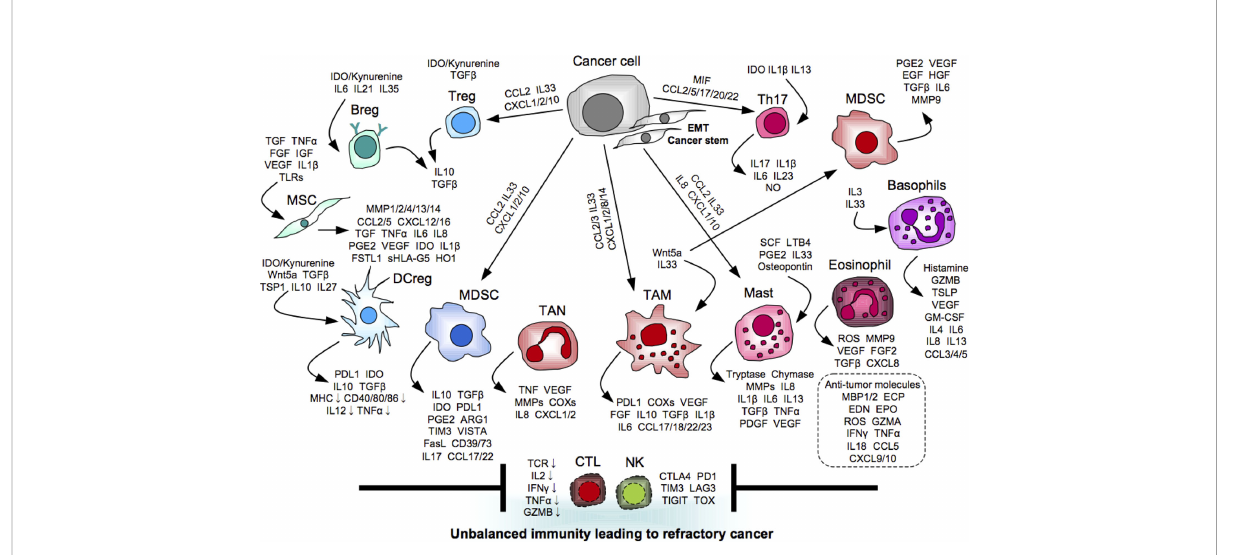
FIGURE 1 Myeloid orchestration leading to refractory cancer. Myeloid cells promote tumor progression and metastasis directly and indirectly via providing unbalanced immunity mediated by immunosuppressive and pro-in fl ammatory molecules to interfere induction and activation of anti-tumor effector